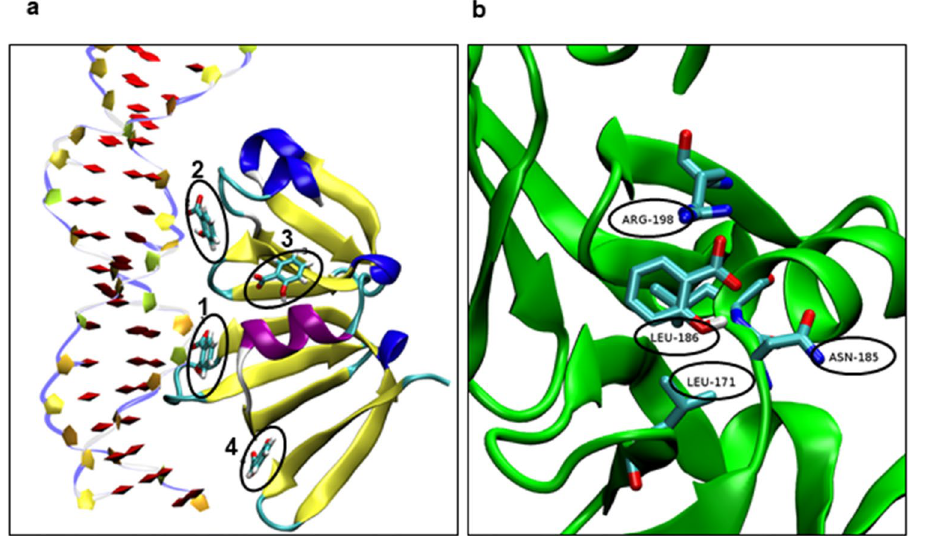
Figure 5. In silico determination of potential interaction sites on AgrA with SAL. ( a ) The figure depicts 4 interaction sites between SAL and AgrA overlapping a DNA fragment, determined by the AutoDock4 v4.2.6 and AutoDock Vina v1.1.2 softwares 28,29 . The AgrA regulator is shown with a “New Cartoon” representation with α-helixes, β-sheets and loops are represented in magenta, yellow and blue colors, respectively. The DNA fragment is shown with a “PapeChain” representation with phosphates groups, deoxyribose residues and nitrogen bases shown in blue, yellow and red colors, respectively. SAL is shown in each site (1–4) with an ellipse, with a “Licorice” representation with C, O and H atoms shown in cyan, red and white colors, respectively. ( b ) The figure depicts the predicted complex between AgrA and SAL in site 1, with the main amino acid residues involved in the interaction denoted by ellipses (Leu-186, Leu-171, Arg-198, and